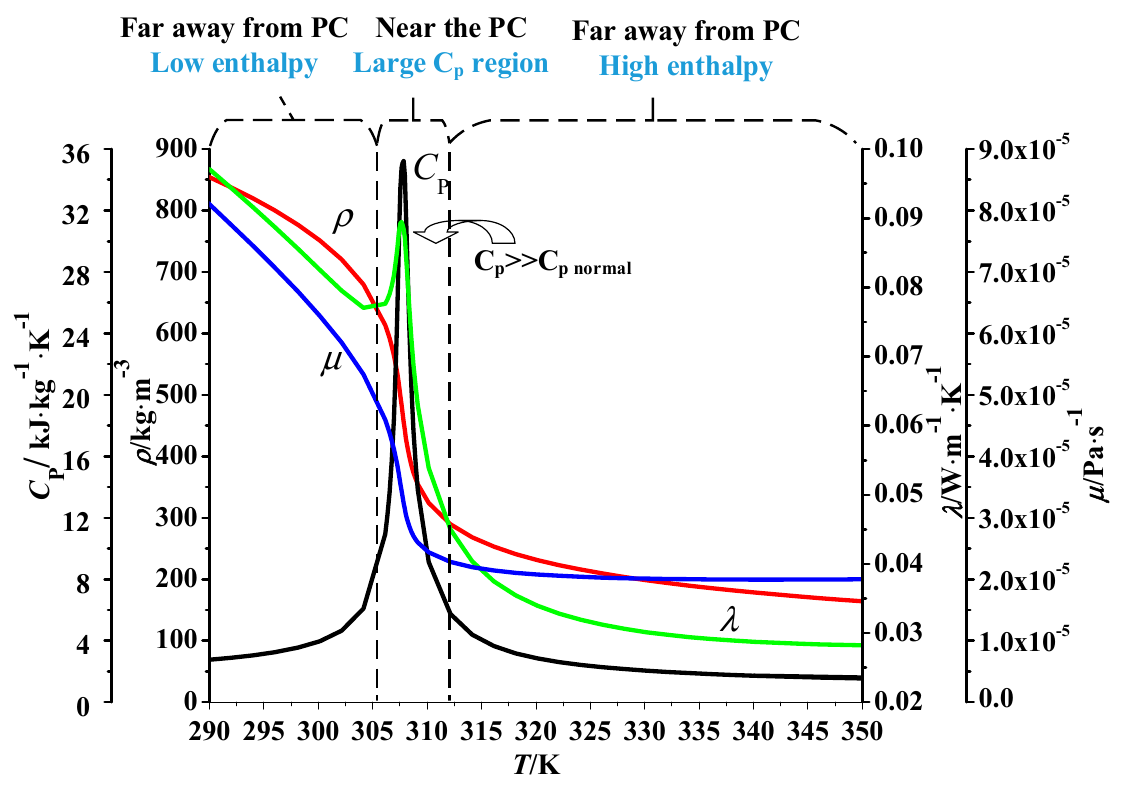
Figure 1. Thermo-physical properties of CO 2 at 8 MPa [19].